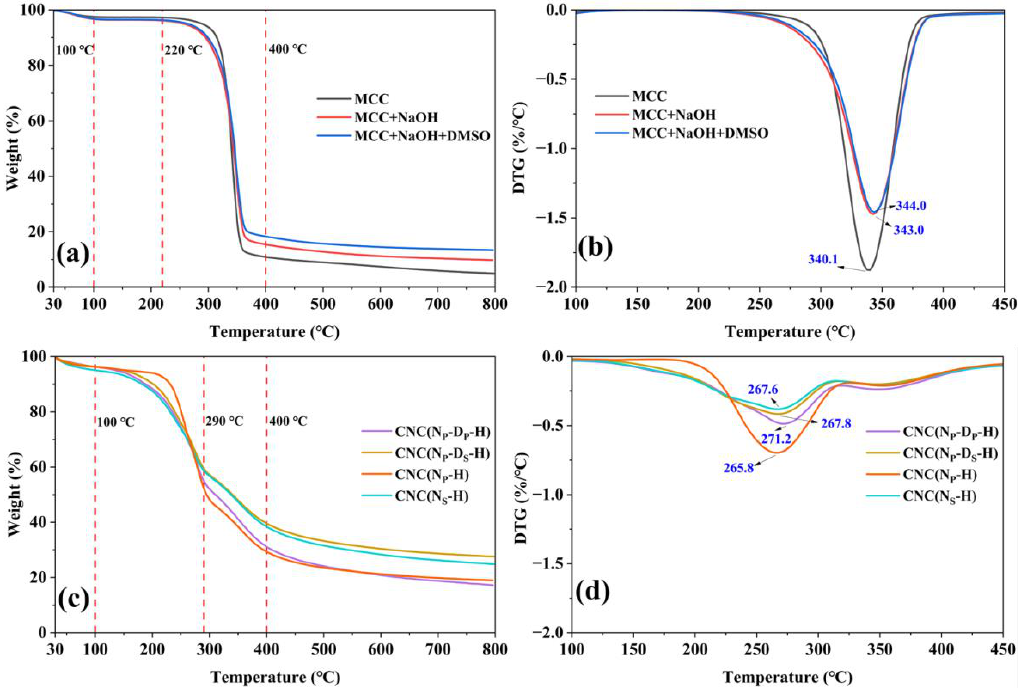
Figure 6. ( a ) TG and ( b ) DTG curves of MCC, MCC after alkaline treatment and MCC after alkaline treatment and swelling treatment; ( c ) TG and ( d ) DTG curves of CNC samples prepared through different pretreatment